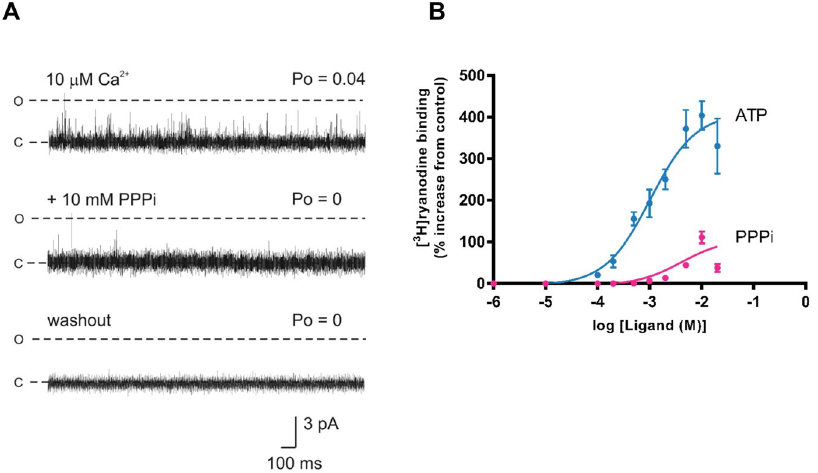
Figure 3. Irreversible RyR2 inactivation by PPPi. ( A ) The top trace shows a typical single RyR2 channel activated by 10 μ M cytosolic Ca 2 + alone. The subsequent trace shows an example of the inactivating effects of 10 mM PPPi. Occasional, very brief openings were observed initially as shown in the middle trace but after 140 s no further openings were detected. The bottom trace shows that after perfusing away the PPPi from the cytosolic chamber, the channel remains shut (no openings during the 3 min recording period). The holding potential was 0 mV. O and C represent the open and closed channel levels respectively. ( B ) Comparison of the stimulation of [ 3 H]ryanodine binding to vesicles of sheep cardiac heavy SR by ATP (blue) and PPPi (pink). The results are expressed as a percentage of the control binding at 10 μ M cytosolic Ca 2 + which was 0.18 ± 0.02 pmol [ 3 H]/mg protein (SEM; n = 10). Where not shown, error bars are within the symbol. The optimum